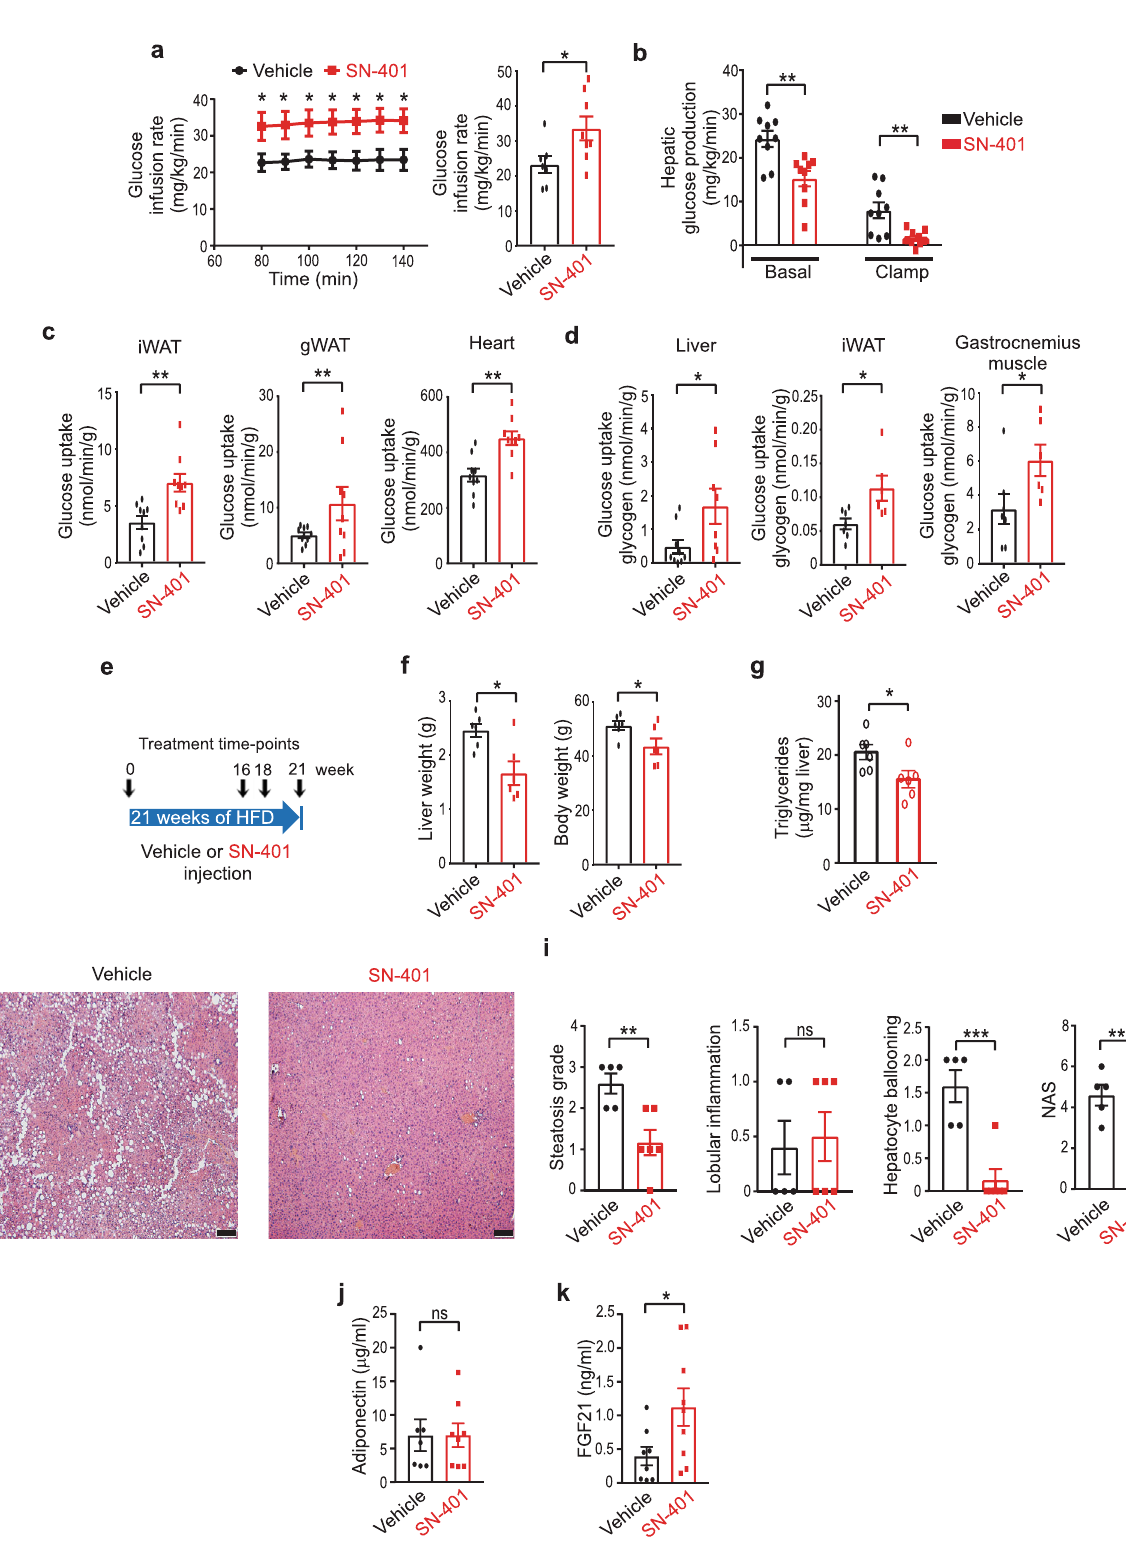
utilized sixfold symmetry expansion and symmetry relaxation 51 and were able to resolve two distinct poses for SN-407 with similar occupancy. Pose 1 shows the drug oriented vertically in the channel ’ s selectivity fi lter in a manner that is similar to that observed for DCPIB/SN-401, but with the lengthened carboxylate chain coiling to maintain its interaction with R103 (Fig. 7a). In Pose-2, SN-407 is tilted off the SWELL1 central axis, positioning